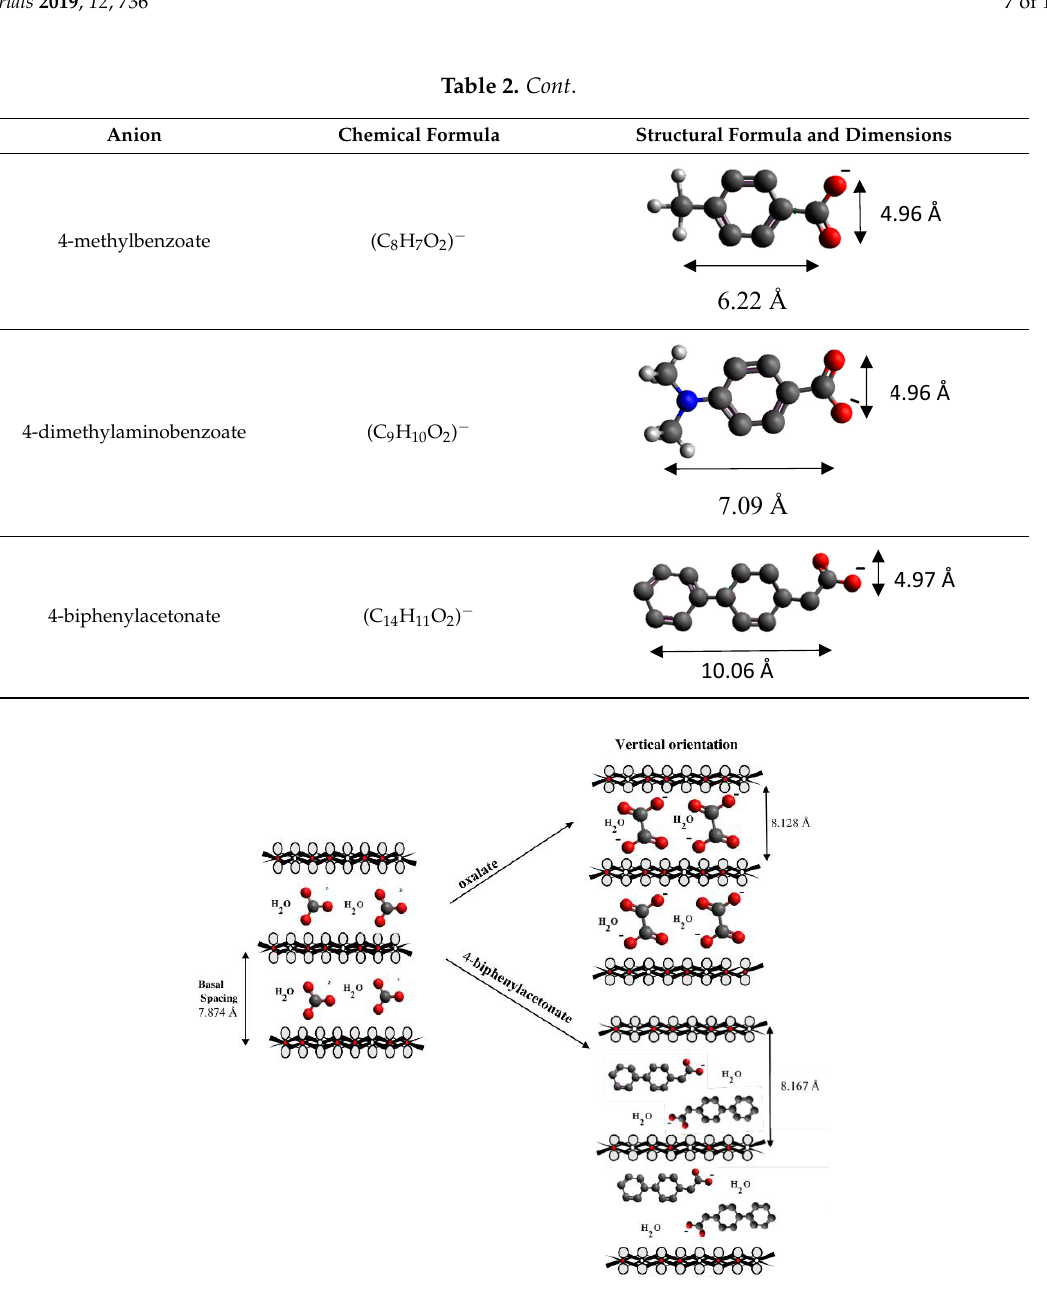
Figure 3. A schematic structure of LDHs with interlayer carbonate anion and the specific orientation of oxalate and 4-biphenylacetonate anions between the layers.